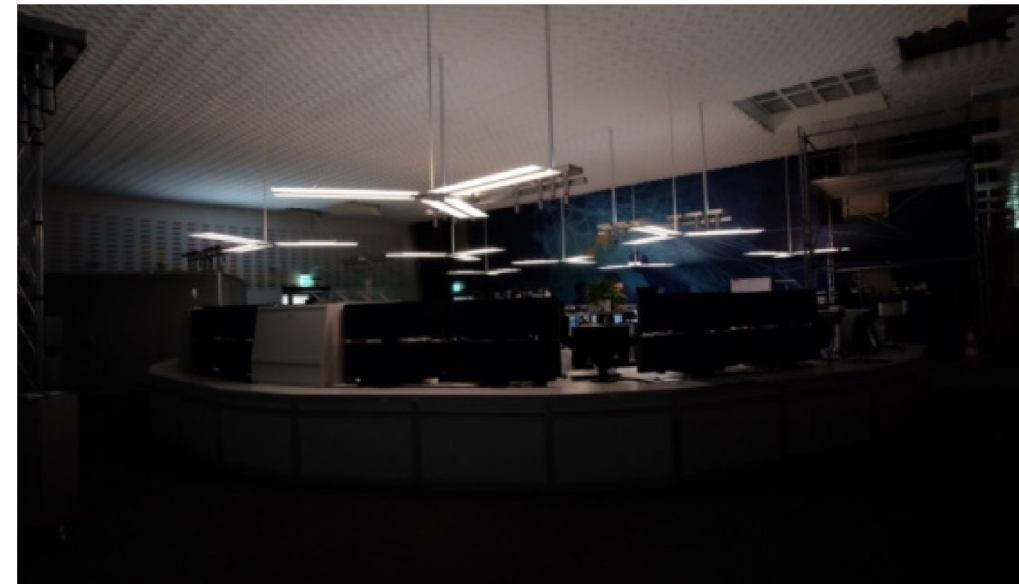
Figure 2. Light scenario during the night when workload is low A B